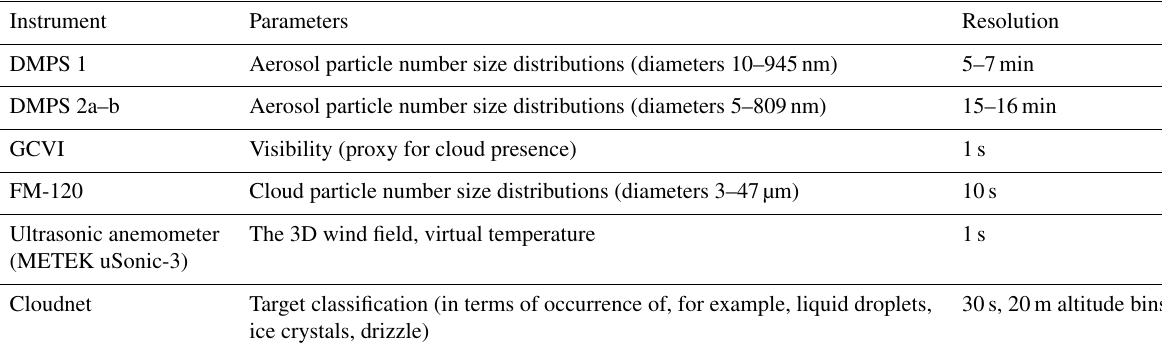
Figure 1. Schematic illustration of the experimental set-up at Zeppelin Observatory. The diagram shows how the whole-air inlet (orange) and the ground-based counterflow virtual impactor (GCVI) inlet (blue) are connected to the differential mobility analysers (DMAs) and condensation particle counters (CPCs). The three-way valve switches the sample flow to the instruments on the left-hand side from the GCVI inlet to the whole-air inlet when there is no cloud to be sampled. Cloud sampling is activated if the visibility drops below 1km (measured by a visibility sensor, not pictured, next to the GCVI inlet). Auxiliary measurements from a fog monitor and an ultrasonic anemometer have also been included in the data analysis. Table 1. List of instruments, measured parameters, and their temporal and/or spatial